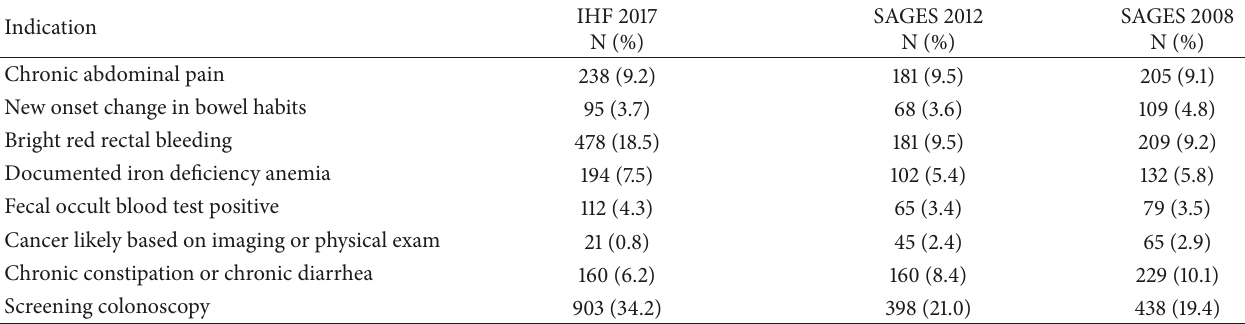
Table 3: Indications for colonoscopy for this IHF, the Society of American Gastrointestinal and Endoscopic Surgeons 2008 and 2012 surveys [6,